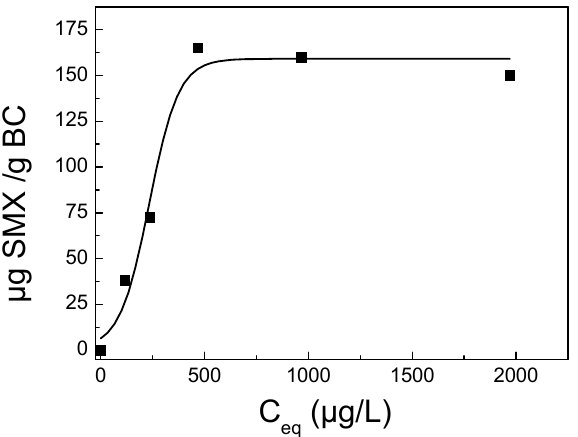
Figure 7. Adsorption isotherm of sulfamethoxazole (SMX) at pH = 6.5, ambient temperature, and 200 mg/L biochar.